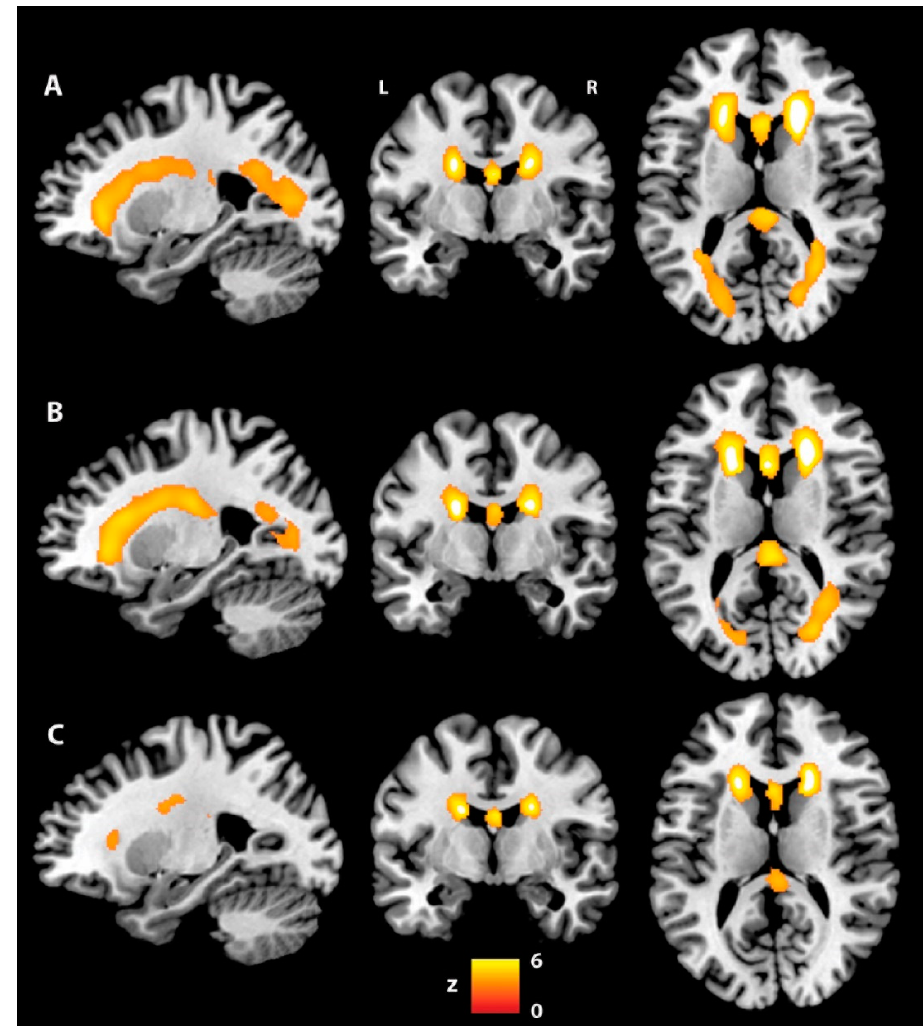
Figure 2. WMH maps created by means of a one-sample t -test (cluster-forming threshold p < 0.001; FWE-corrected at cluster level): ( A ) AP-PT group; ( B ) NA-PT group; ( C ) CU group. FWE: Family wise error, L: Left, R: Right, WMH: White matter hyperintensities.